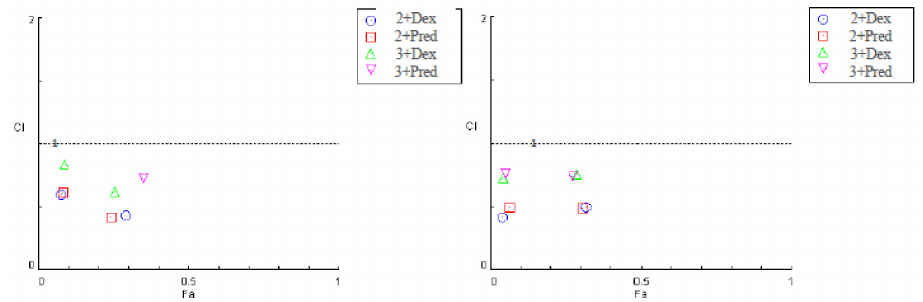
Figure 5. Synergistic effect of flavanone-derived γ -oxa- ε -lactones (3.125 µ g/mL) combined with dexamethasone (Dex) or prednisolone (Pred) (2.5 µ g/mL) in CLBL-1 ( A ) and CLB70 ( B ) cell lines. The values are means of two independent experiments. Statistical differences were analyzed using one-way ANOVA followed by Tukey’s multiple comparison test. Values without common letters (a, b, c) in the superscript differ statistically ( p < 0.05). Combination index (CI) versus fraction affected (Fa) for combination of lactone 2 and 3 with dexamethasone and prednisolone was calculated using the Chou–Talalay method. Synergy was defined by CI values <1.